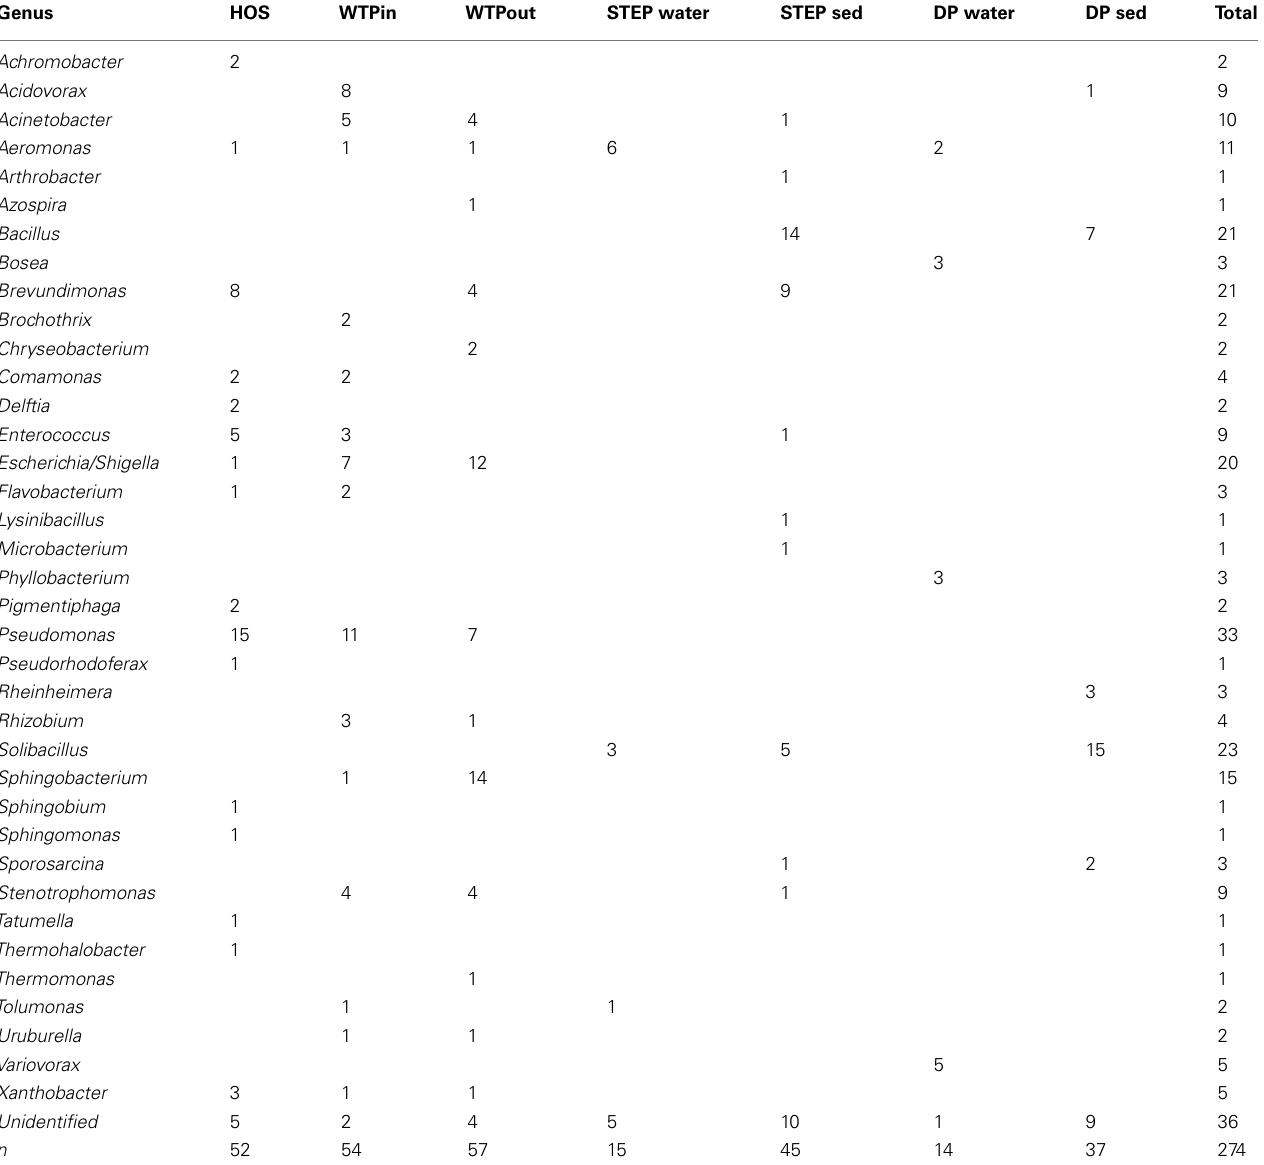
Table 2 | Genera of Sul/Trm/Str resistant bacteria isolated from HOS,WTPin, andWTPout according to partial 16S rRNA gene sequences and their numerical distribution in the different wastewater